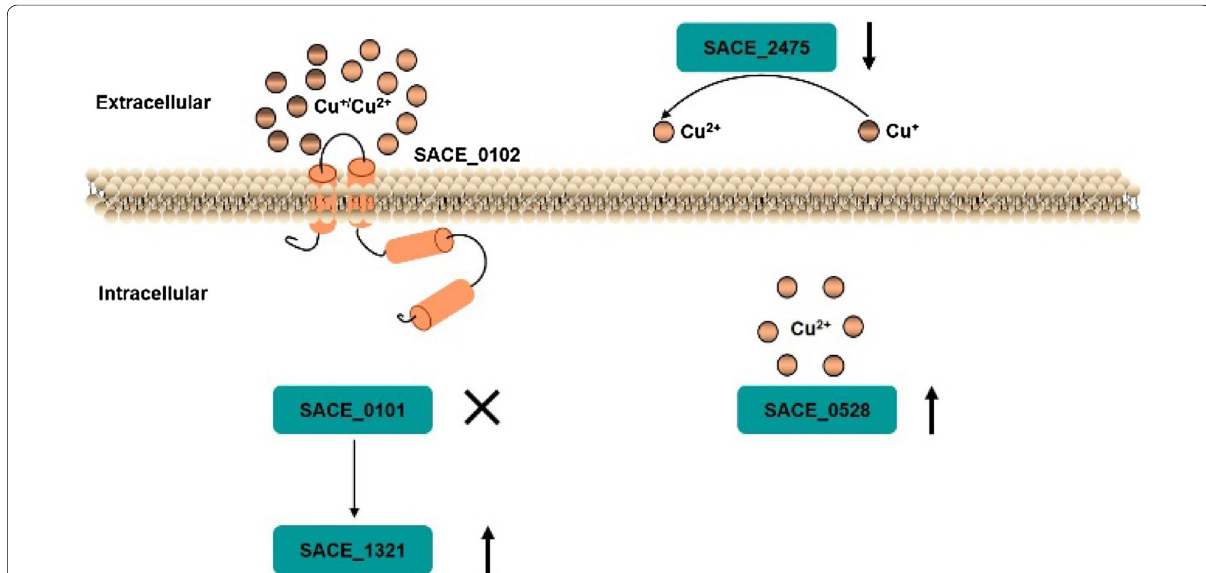
Fig. 7 Simple model of copper homeostasis mechanism in S. erythraea . SACE_0528 and SACE_1321 were up-regulated with the deletion of SACE_0101, while SACE_2475 down-regulated. The protein encoded by SACE_0102 recognizes extracellular Cu 2 + , followed by autophosphorylation and phosphotransfer to the response regulator (encoded by SACE_0101). Phosphorylated regulator affects or regulates the transcriptional level of three downstream genes. This resulted in a transcriptional activation of SACE_0528 and SACE_1321 and inactivation of